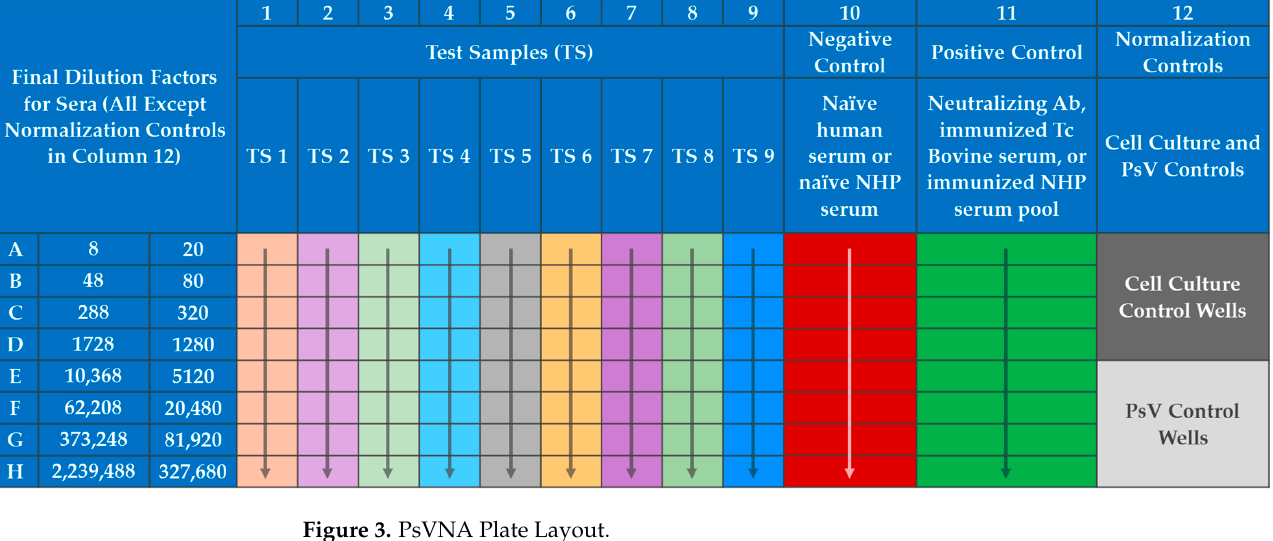
Figure 3. PsVNA Plate Layout.